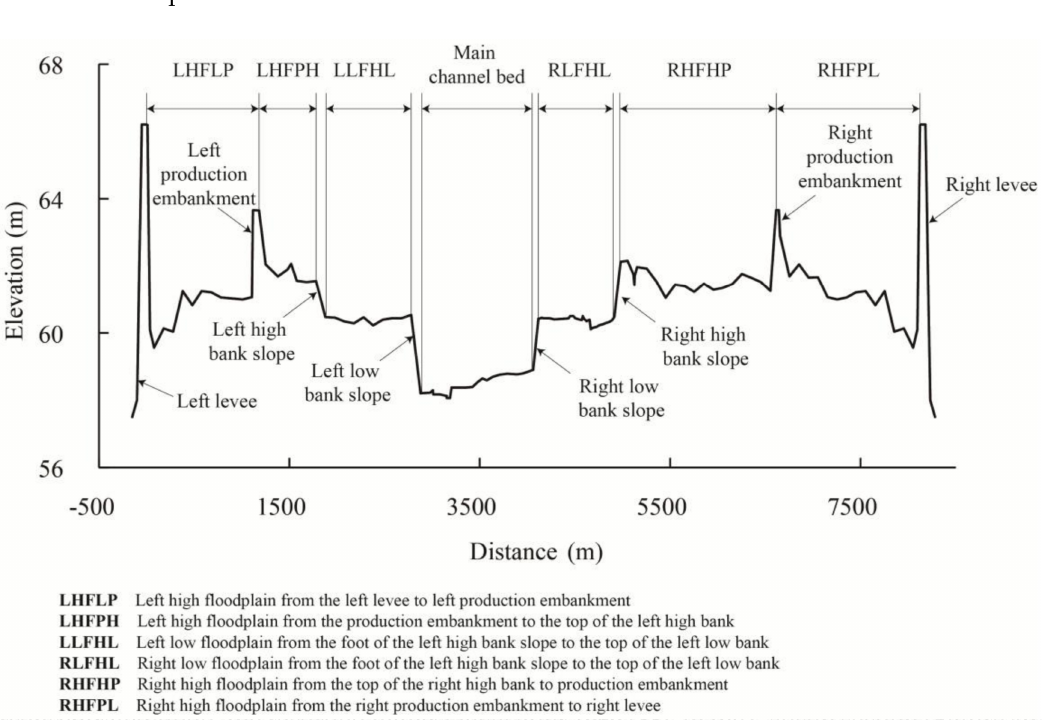
Figure 2. A channel cross-section of the lower Yellow River, showing a complete division of geomorphic